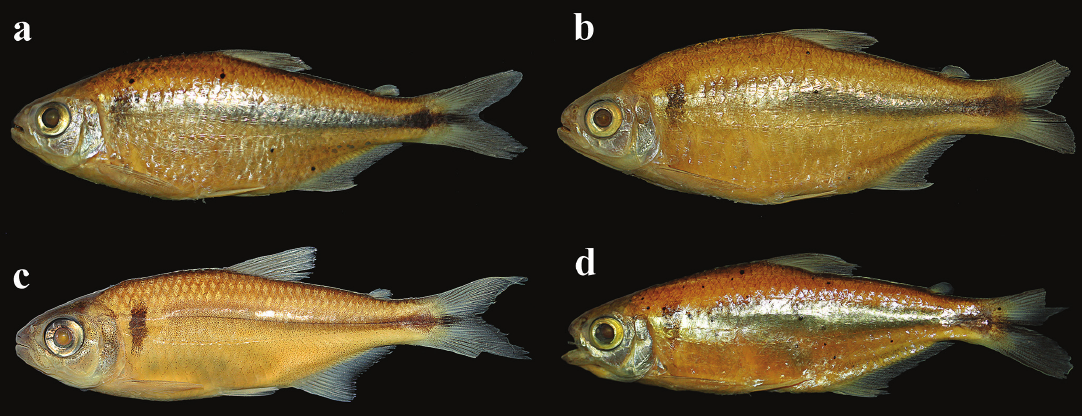
Fig. 6. Recently collected specimens of Deuterodon pedri showing variability according to sex and body size: a, female, MCN 19697, 79.82 mm SL; b, female, MCN 19698, 85.70 mm SL; c, juvenile, MNRJ 38463, 51.18 mm SL; d, male, UFRGS 17543, 86.47 mm SL.